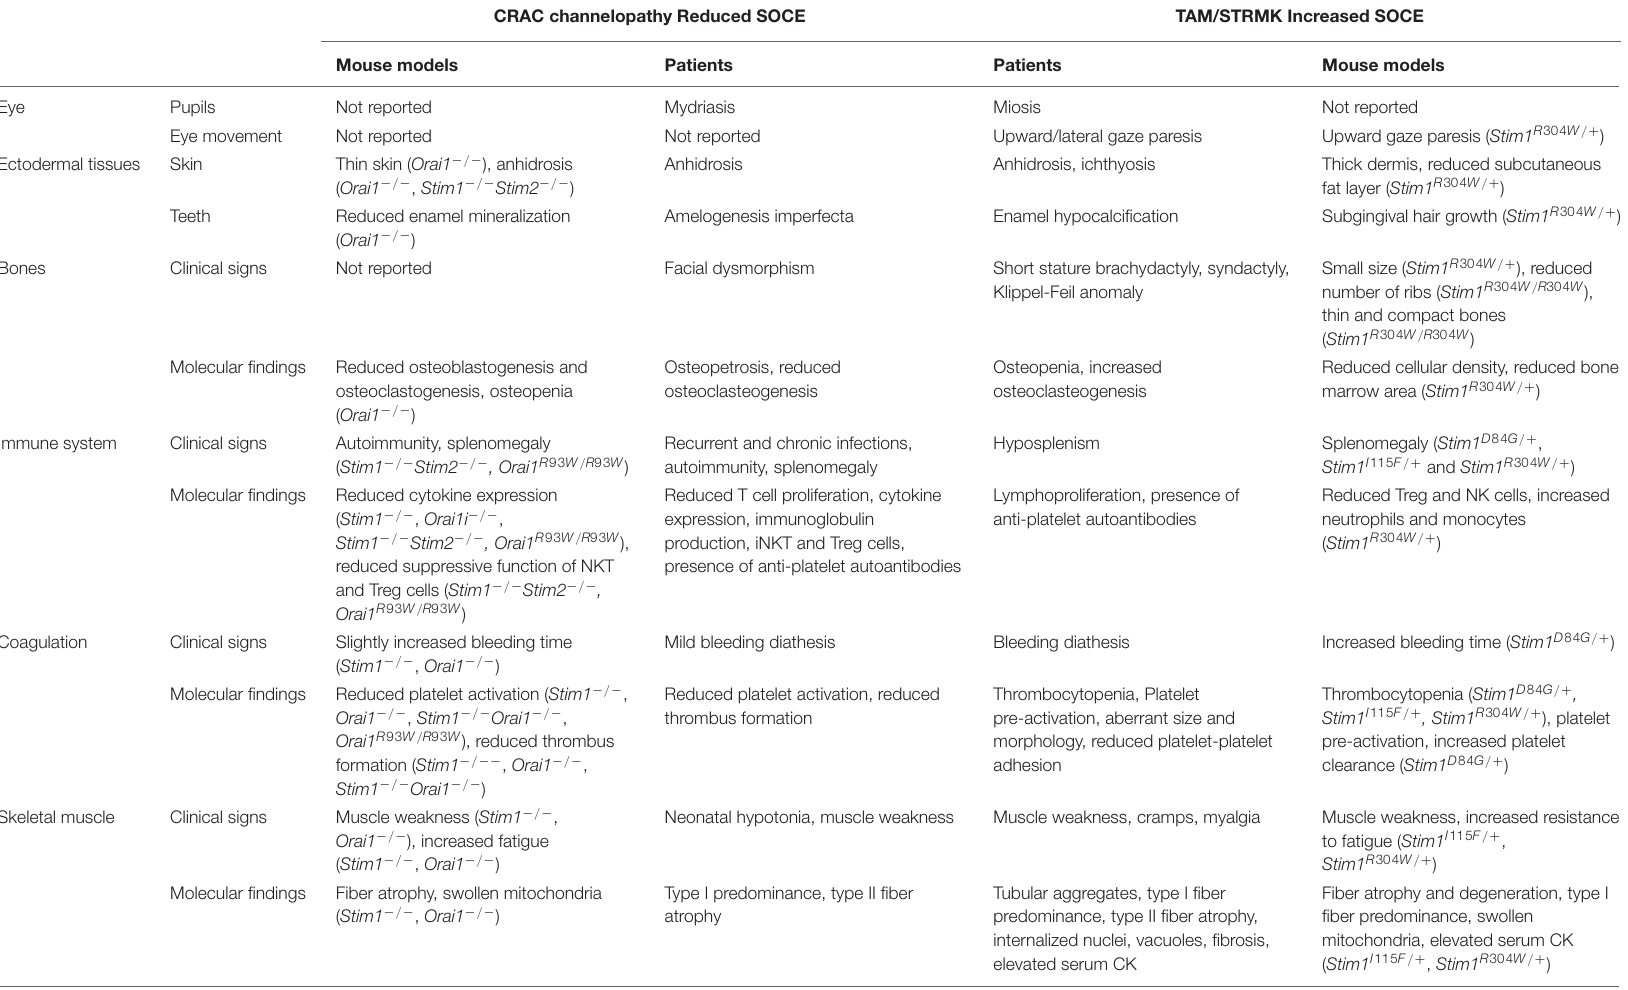
TABLE 1 | Descriptive comparison of the clinical signs and physiological defects in CRAC channelopathy and TAM/STRMK patients and mouse